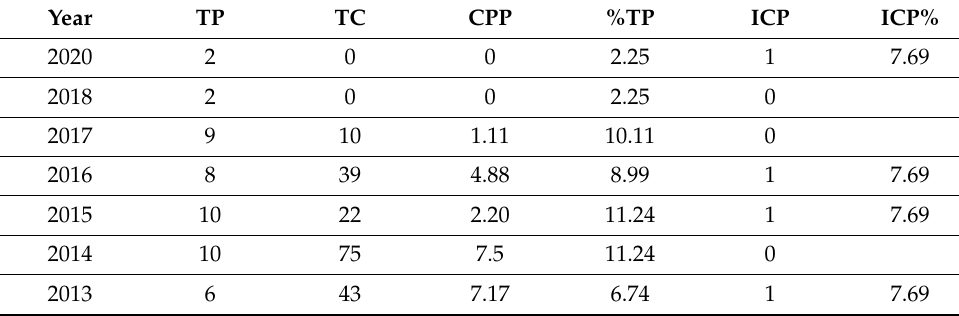
Table 1. Dhat syndrome research- year-wise output (n =